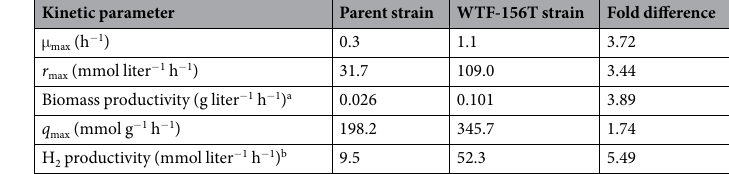
Table 1. Kinetic parameters of the parent and WTF-156T strains. Kinetic parameters were calculated with data from the graphs in Fig. 2. μ max , maximum specific growth rate; r max , maximum H 2 production rate; q max , maximum specific H 2 production rate. a Biomass productivity was determined by dividing total yield by time difference from 11 to 13 h for the parent strain and from 2 to 4 h for WTF-156T strain. b H 2 Productivity was determined by dividing the total yield by